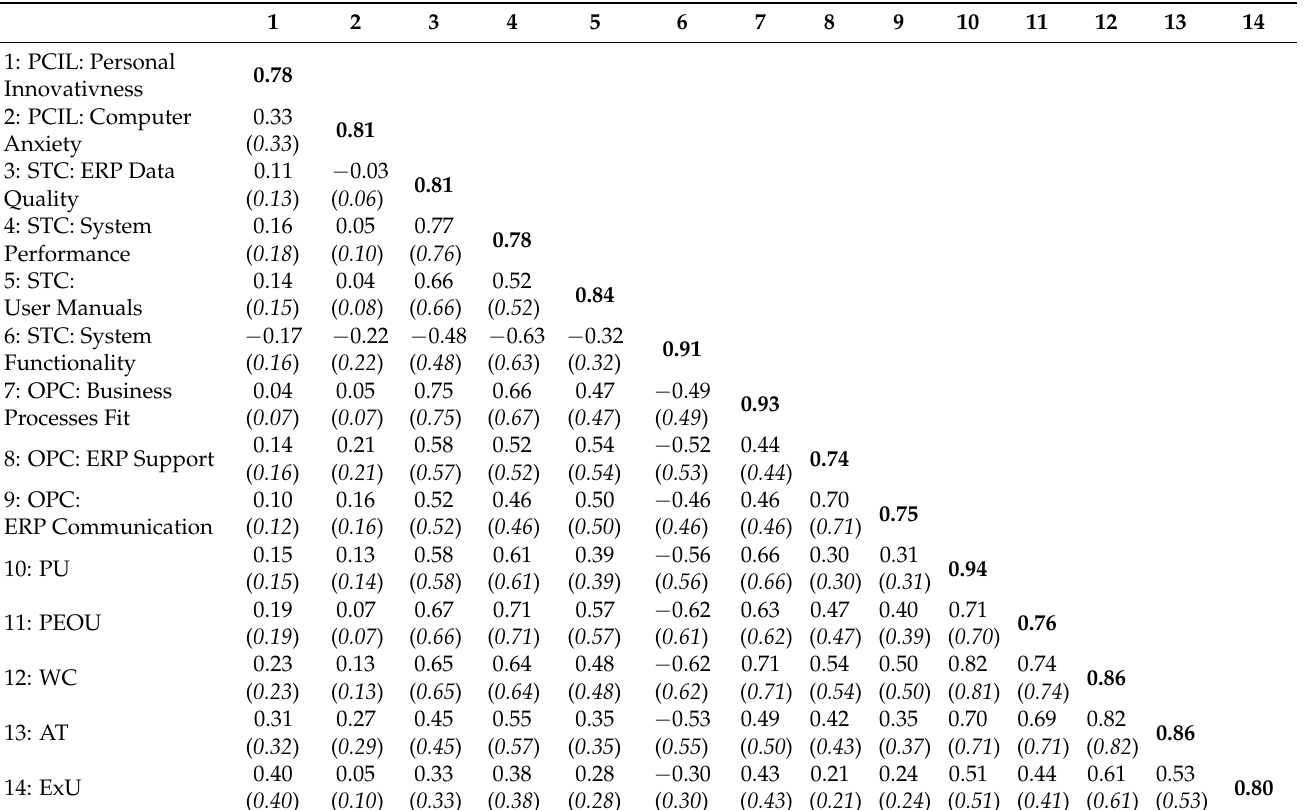
Table 4. Results of discriminant validity (intercorrelation of the latent variables and HTMT vari- ables